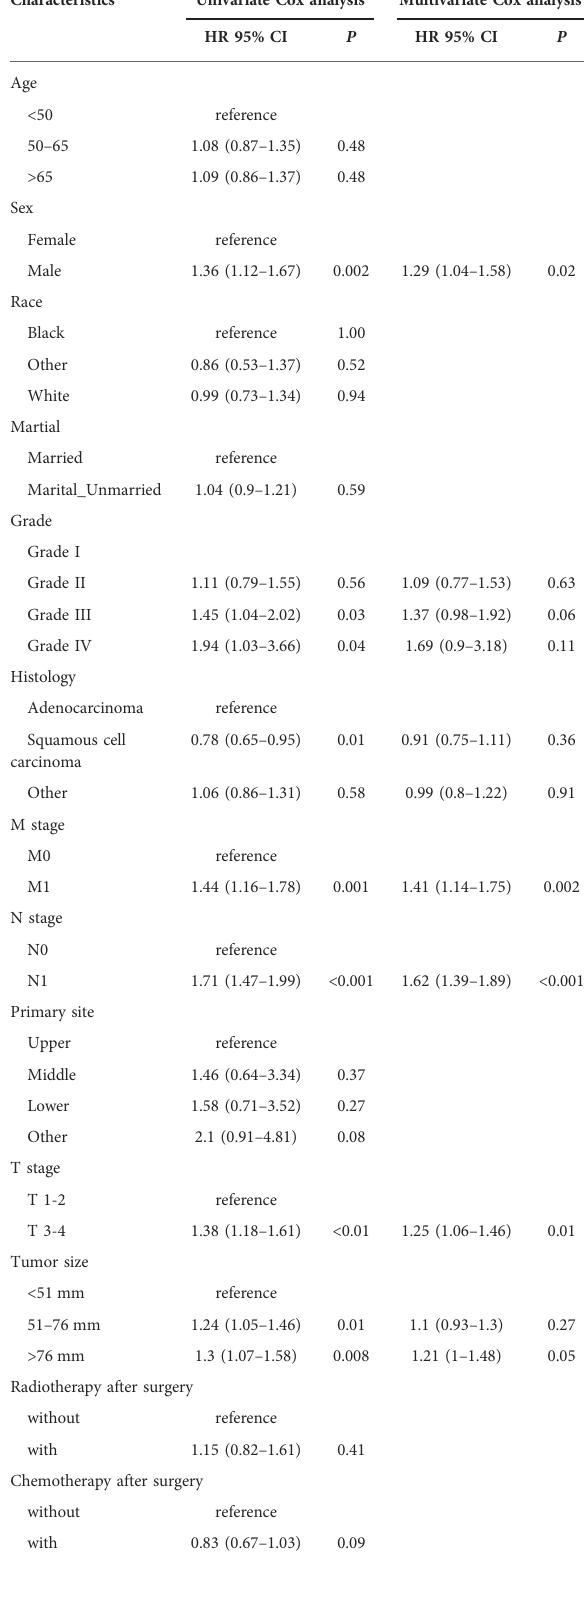
TABLE 2 Univariate and multivariate Cox analysis of cancer-speci fi c survival for esophageal cancer patients receiving neoadjuvant chemoradiotherapy in the training